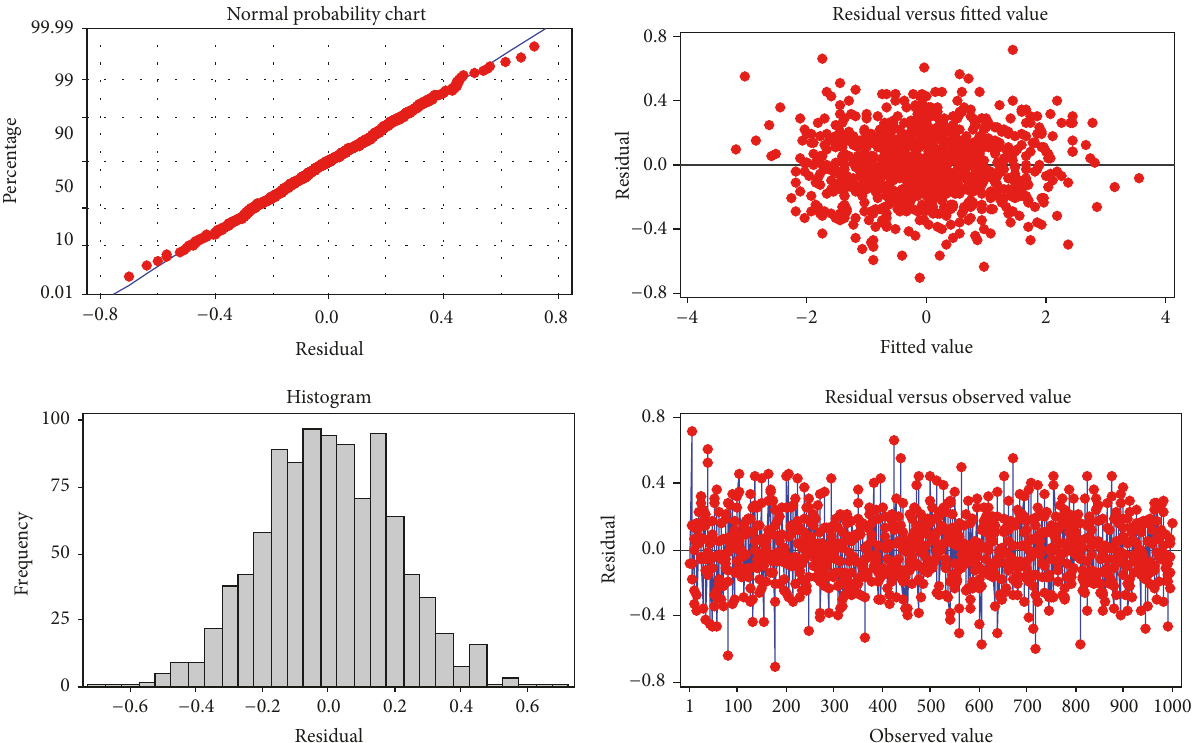
Figure 16: Residual plots for the adequacy check of the approximation equation for base shear.